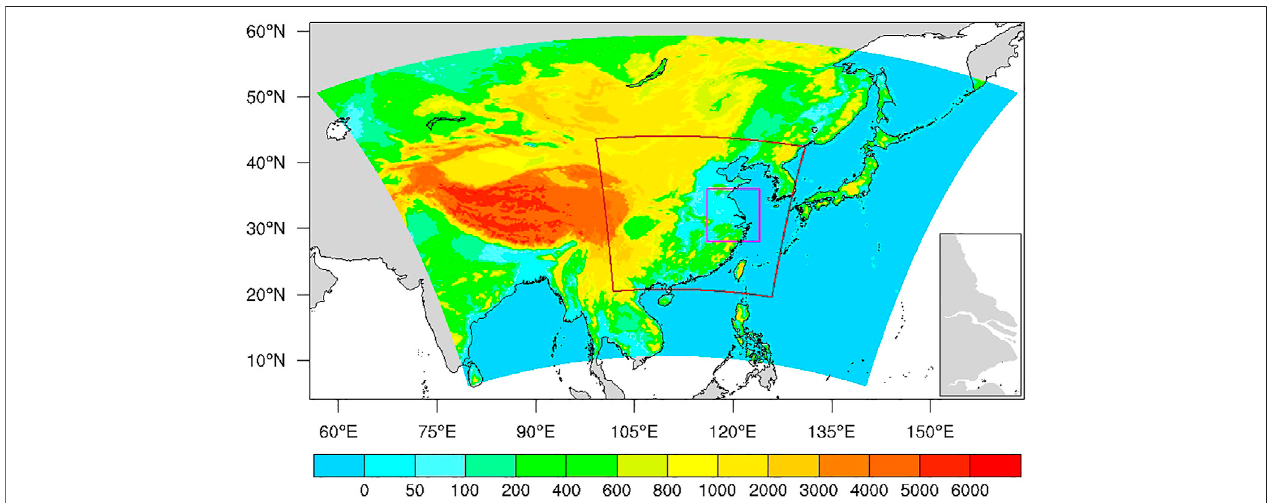
FIGURE 1 | Domains in the PWAFS model and corresponding topography ( m ), with the 3 km nested domain marked by the inner brown box. The purple outline denotes the study area. The coastal areas of YHR are attached at the right bottom.